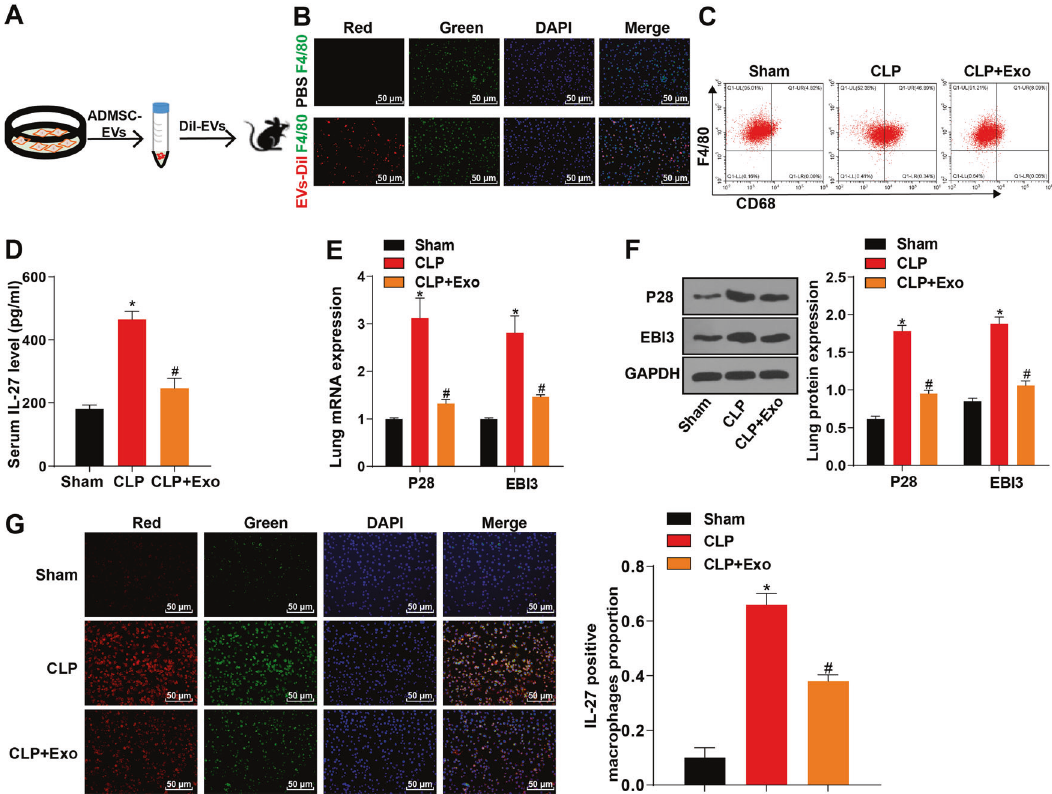
Fig. 4 ADMSC-exosomes reduced the number of pulmonary macrophages and the release of IL-27 in sepsis mice. A ADMSC-exosomes were isolated, puri fi ed and labeled with Dil dye; fl ow chart of injection in CLP sepsis mice. B The co-localization of exosomes (Dil pre-labeled red) and macrophages (F4/80, green) in lung tissue was detected using immuno fl uorescence staining, scale bar = 25 μ m. C The number of macrophages CD68 + F4/80 + in single-cell suspension of whole lung tissue was detected using fl ow cytometry. D The content of IL-27 in serum of CLP mice treated with ADMSC-exosomes was detected using ELISA. E The mRNA expressions of P28 and EB13 in lung tissue of CLP mice treated with ADMSC-exosomes were detected using RT-qPCR. F The protein levels of P28 and EB13 in lung tissue of CLP mice treated with ADMSC-exosomes were detected using Western blot. G The content of IL-27 in macrophages after the treatment of ADMSC-exosomes or not detected using immuno fl uorescence. Blue fl uorescence indicated DAPI, green fl uorescence indicated F4/80, and red fl